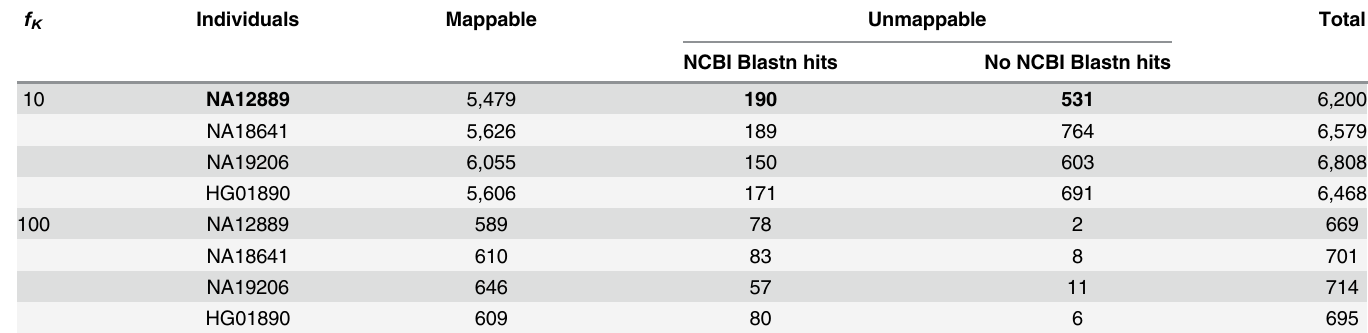
Table 2. The number of classified repeats constructed by REPdenovo on four different human individuals for f K = 10 and 100. Classified into: (i) mappable to the reference genome, (ii) unmappable to the reference but have NCBI Blastn hits, and (iii) unmappable to the reference and no NCBI Blastn hits. The repeats in (ii) and (iii) may potentially be previously unknown